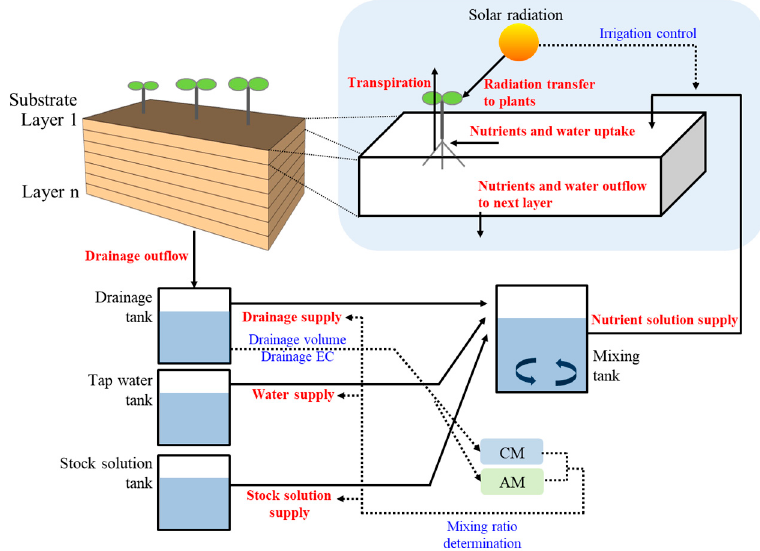
Figure 1. Schematic description of a closed-loop soilless culture system in a simulated condition. Solid lines indicate water and nutrient flow, and dotted lines indicate data flow for nutrient solution mixing and irrigation control. CM and AM mean conventional and alternative nutrient-replenishment methods, respectively.